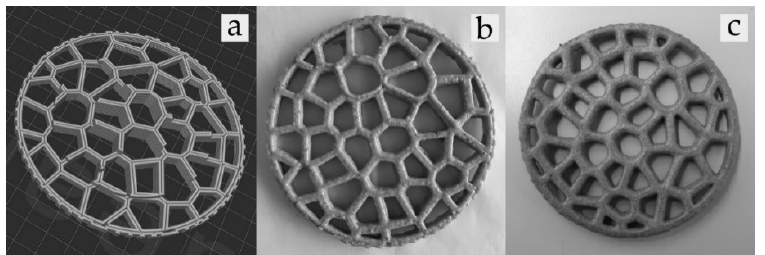
Figure 1. The following photos show ( a ) a 3D visualization created by Webgcode of the Voronoi circle model, ( b ) 3D-printed raw snack, and ( c ) 3D-printed baked snack.